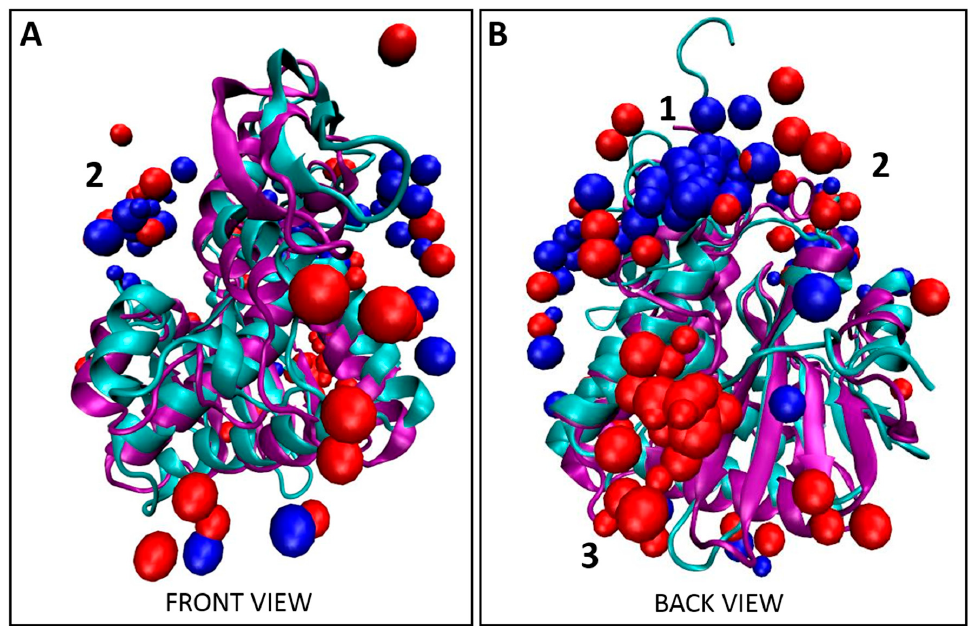
Figure 4. Co-localization of Tier 1 consensus with Tier 1 peptides. ( A ) Front view and ( B ) back view for the overlay of the top 10 decoys, as determined using XPairIt, of the abrax binding peptides A5, A12, A14, and A15 and the Tier 1 consensus on RiVax (bound peptides: red spheres, protein: cyan ribbons) and abrax (bound peptides: blue spheres, protein: purple ribbons). Note the structural similarity between RiVax and abrax but disparity in predicted binding locations of the peptides. Binding locations 1–3 are numbered.